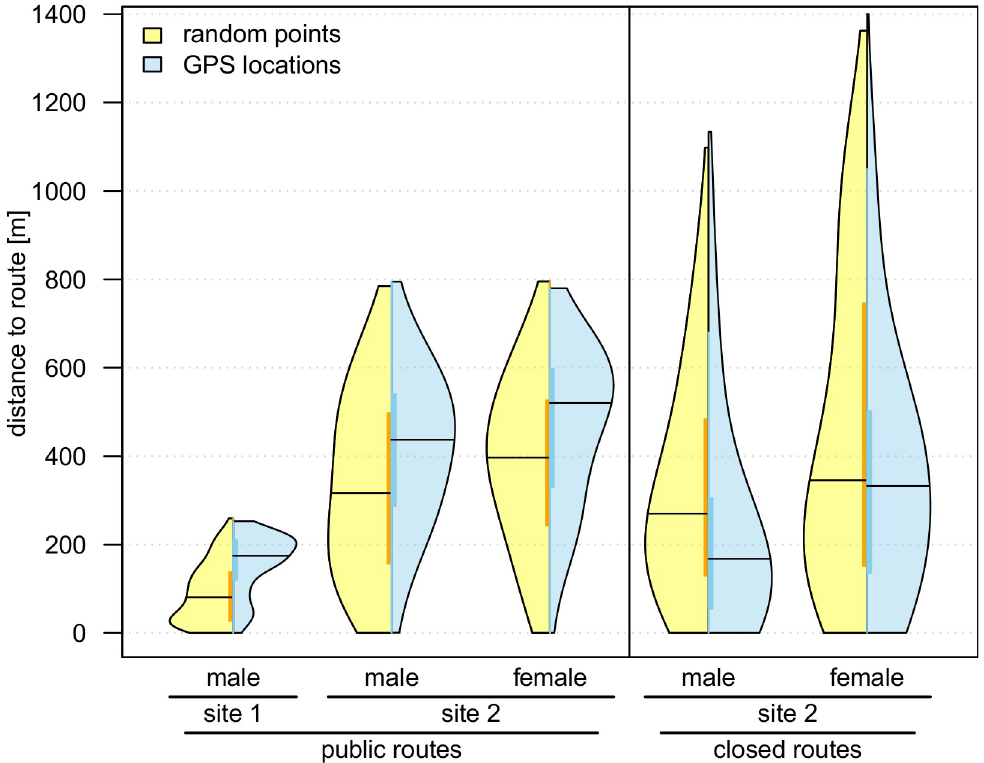
Fig 3. Observed habitat use (GPS locations) versus expected habitat use (random points) alongside routes. Violin plots show distributions of distances towards closest public and closed routes, respectively. Mean values are marked by black horizontal lines, quantiles are indicated by thick, coloured vertical bars. Violin bodies show the kernel density distributions of locations and random points over their distances to routes.